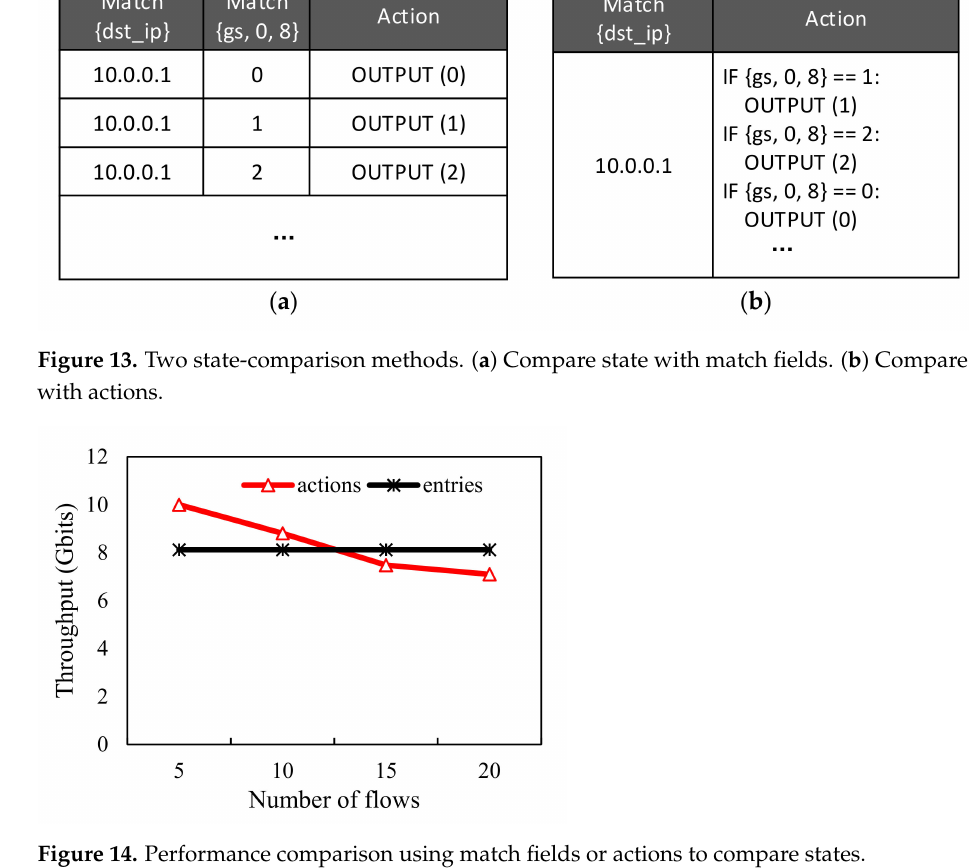
Figure 14. Performance comparison using match fields or actions to compare